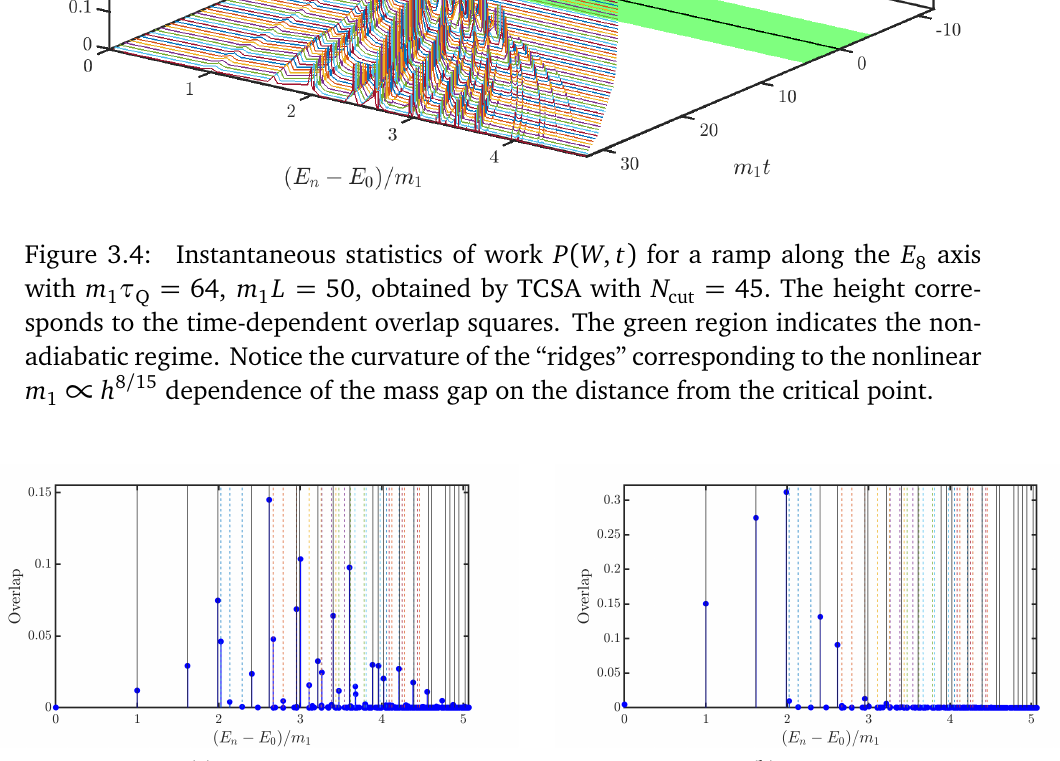
Figure 3.5: Statistics of work after the ramp P ( W , t = τ = 45. States containing only zero-momentum particles are de- L = 40, N with m 1 cut noted by continuous lines, while dashed lines denote different moving multiparticle